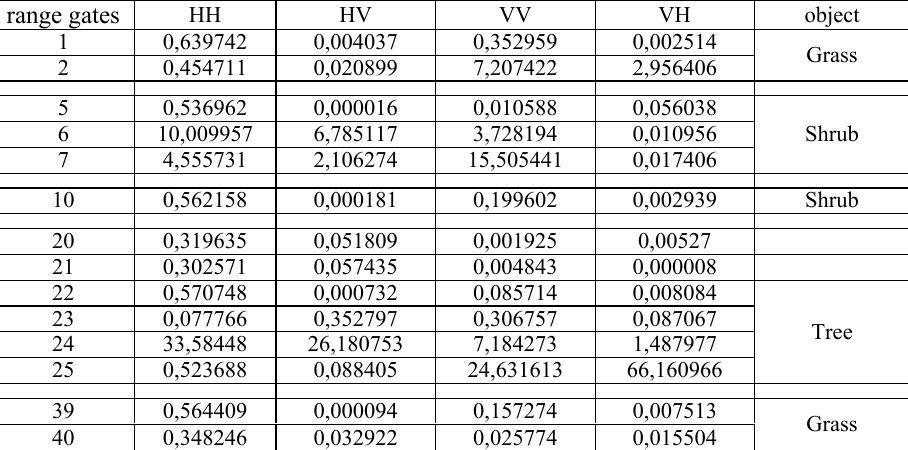
Table 8. Observation contributions for the scene without a